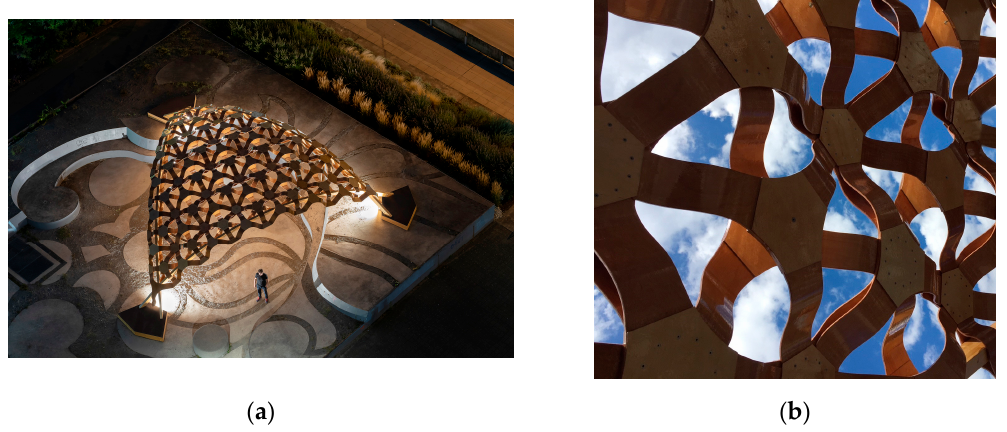
Figure 1. ( a ) The erected BioMat pavilion at the campus of the University of Stuttgart; ( b ) Connections of the modular Design for Deconstruction (DfD) system in combination with structural beams. © BioMat/ITKE- University of Stuttgart.